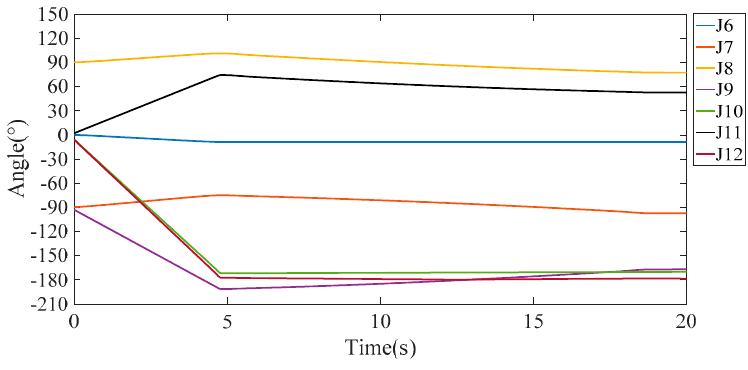
Figure 22. The joint angles of the redundant manipulator.